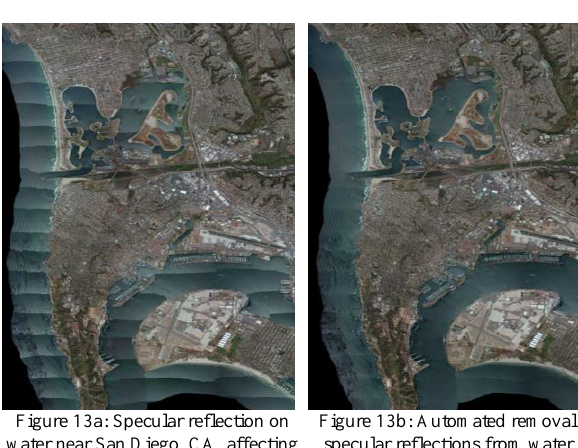
Figure 12b: The cell of Fig. 12a after automated color balancing